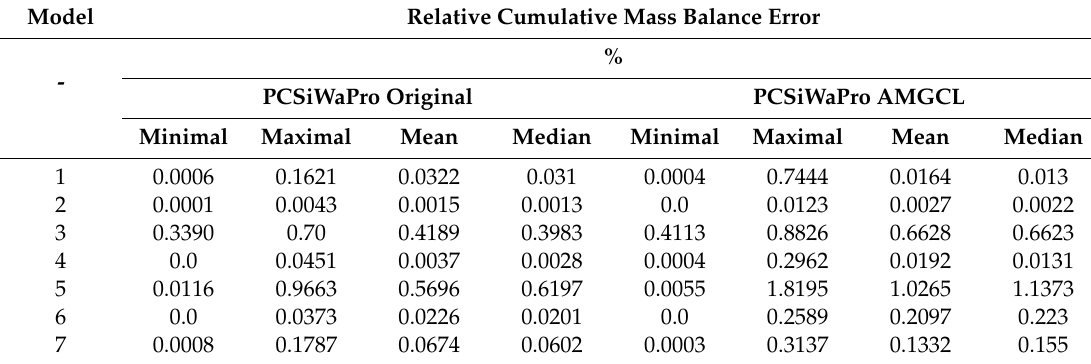
Table 4. Comparison of the RCMBE computed with PCSiWaPro Original and PCSiWaPro AMGCL. Model